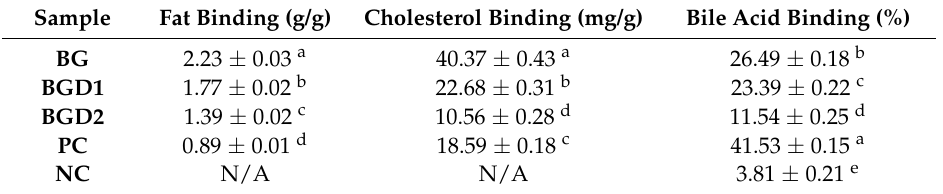
Table 2. The fat-binding, cholesterol-binding, and bile acid-binding capacities of Qingke β -glucans.